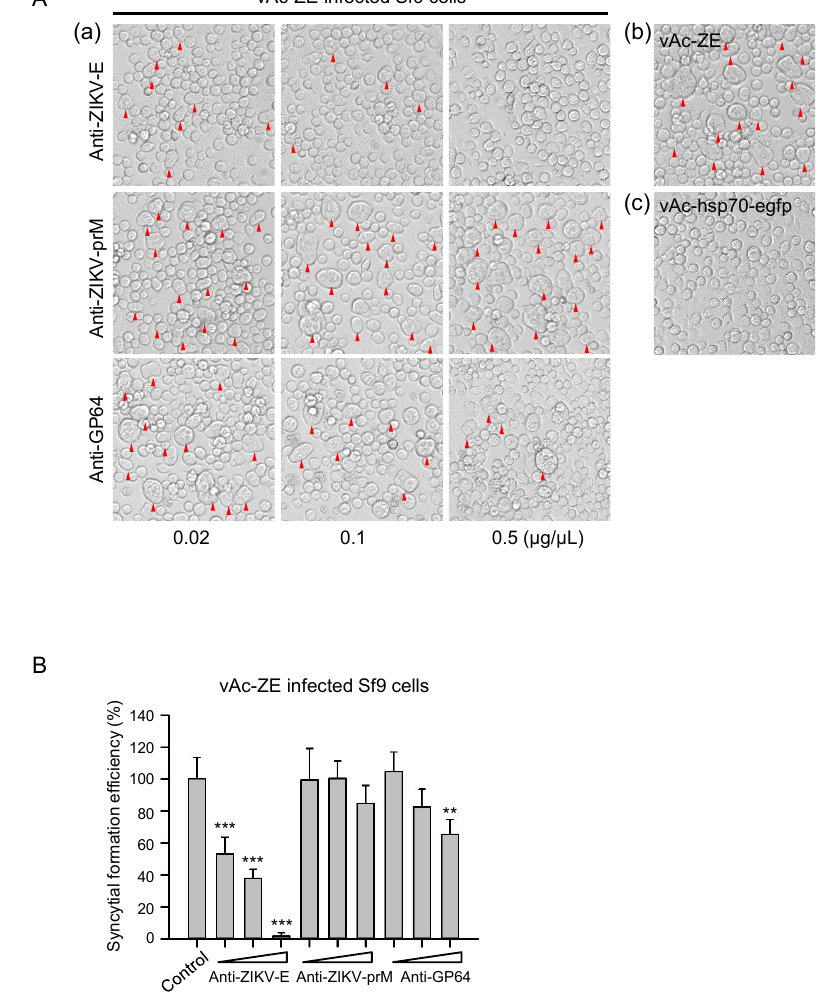
Figure 5. Antiviral determination of polyclonal antibodies. ( A ) ( a ) Cytopathic effect of Sf9 cells infected by vAc-ZE, with increasing concentrations of anti-ZIKV-E polyclonal antibody or unrelated polyclonal antibodies (anti-ZIKV-prM / anti-GP64) mixed in the culture medium. ( b ) Sf9 cells infected with vAc-ZE were used as a positive control. ( c ) Sf9 cells infected with vAc-hsp70-egfp were used as a negative control. ( B ) The number of syncytia within a field of view was counted for statistical analysis. The means and SD correspond to data collected from five random fields of view. Values that are significantly different from control are indicated. ** p < 0.01; *** p <